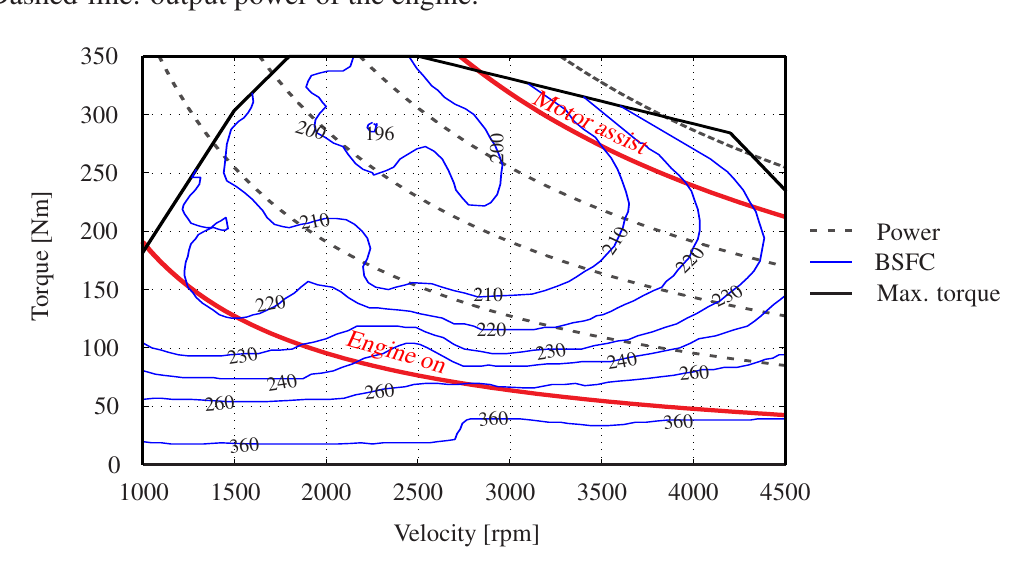
Figure 5. Engine threshold-based control strategy. Blue curves: the brake specific fuel consumption (BSFC) which represents the fuel consumption of the engine at each operating point; Dashed-line: output power of the